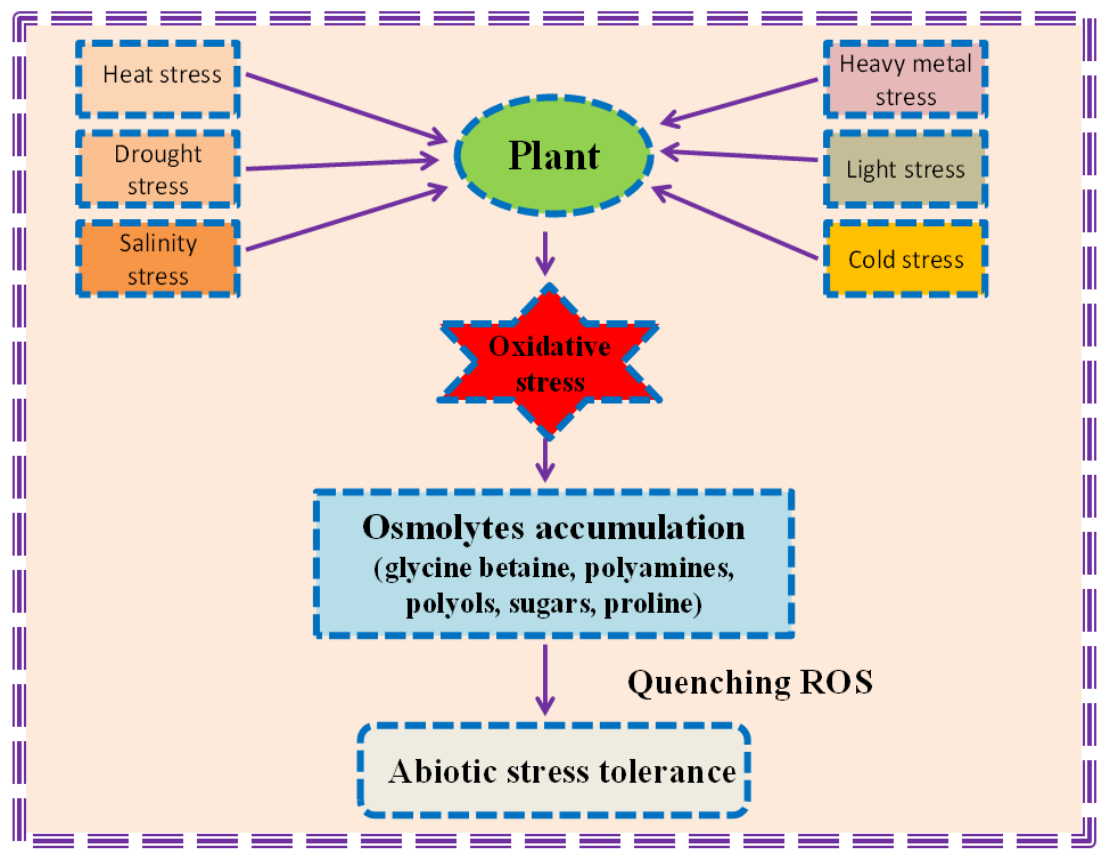
Figure 1. Schematic representation of plants response to various abiotic stresses and the role of osmolytes to counteract reactive oxygen species under stressful conditions.